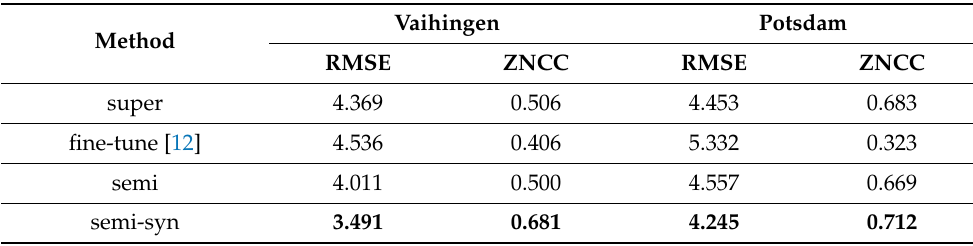
Table 3. Comparison of inter-domain semi-supervised learning to supervised learning, fine- tuning [12], and with or without synthetic data, on Vaihingen and Potsdam datasets. Best results in each category are in bold.